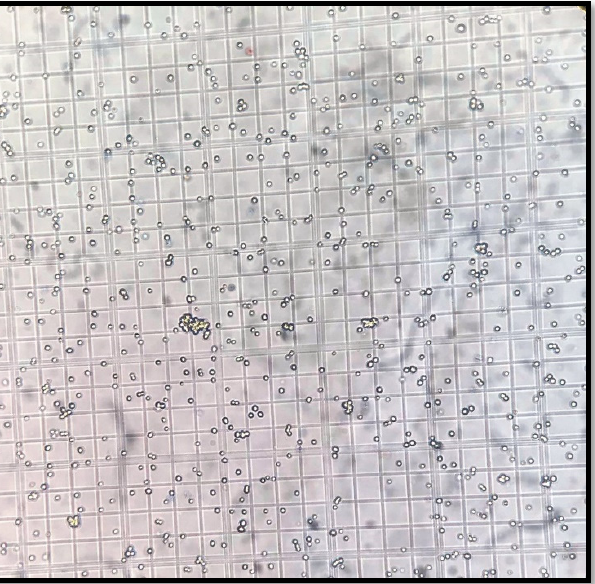
Figure 10. Trypan blue exclusion method shows the viable macrophage cells using a light microscope with 100X power of magnification .